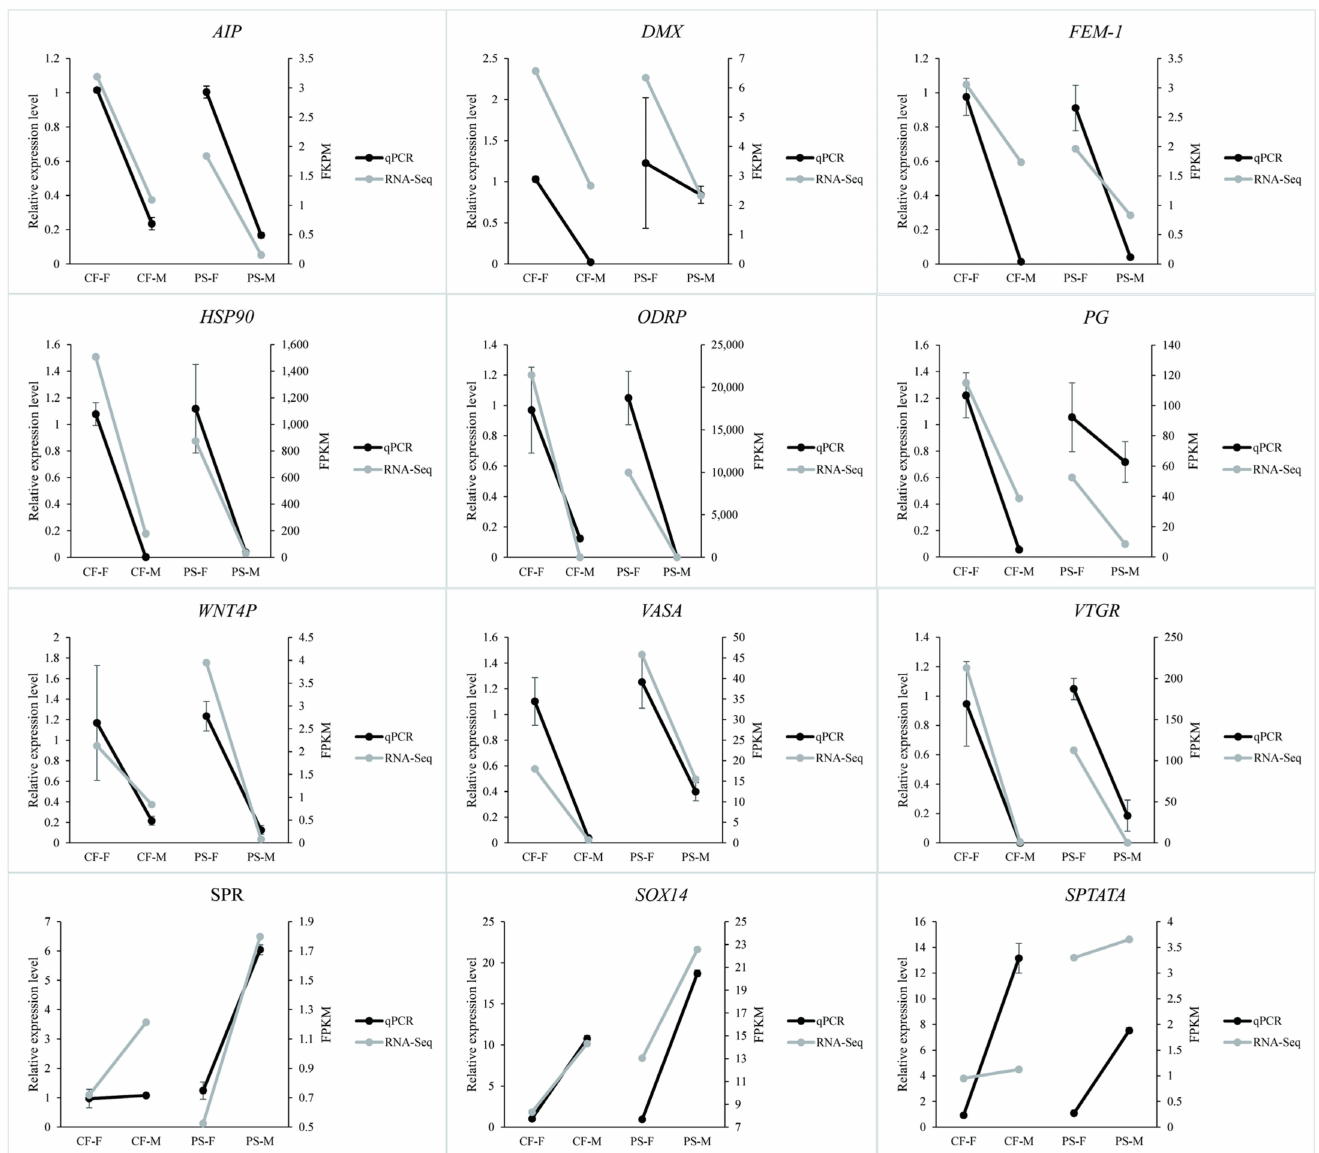
Figure 7. The verification of the genes which have the same expression patterns between sexes of Portunus sanguinolentus and Charybdis feriatus . PS-M represents the male Portunus sanguinolentus and PS-F represents female Portunus sanguinolentus . CF-M represents the male Charybdis feriatus and CF-F represents female Charybdis feriatus